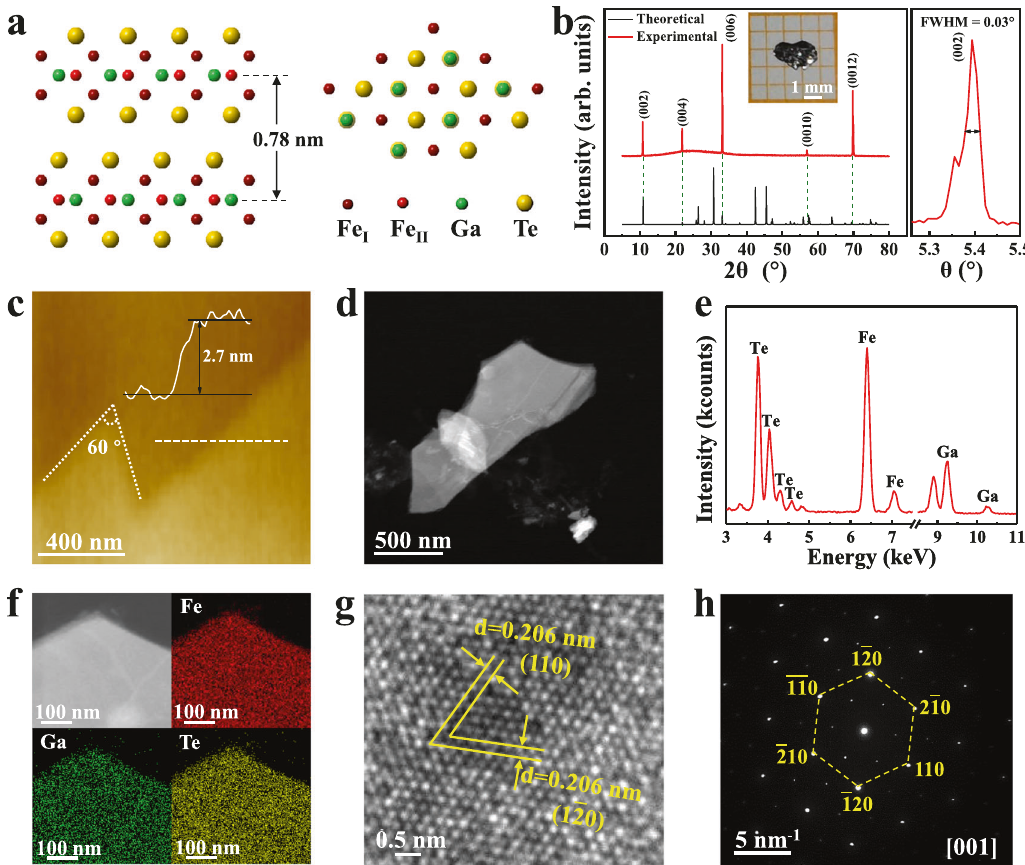
Fig. 1 | Crystal characterization of the vdW layered Fe 3 GaTe 2 single crystals. a Front (left) and top view (right) of the crystal structure of Fe 3 GaTe 2 . b ExperimentalandtheoreticalXRDpatternsoftheFe 3 GaTe 2 bulkcrystal.Theright panelexhibitsthefullwidthathalfmaximum(FWHM)ofthe(002)diffractionpeak. Inset shows an optical image of a typical bulk crystal. c AFM topography of a